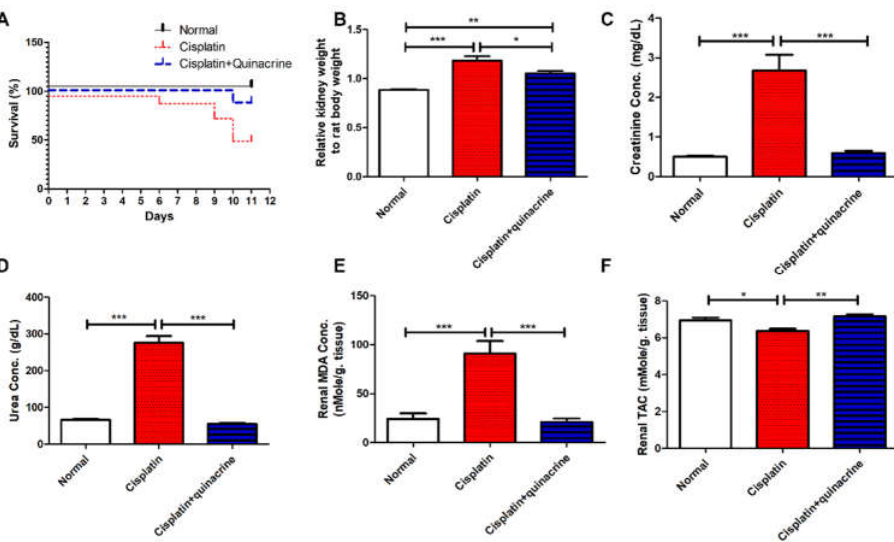
Figure 1. Quinacrine attenuated cisplatin-induced mortality, nephrotoxicity and oxidative stress. Effect of 10 days’ administration of quinacrine (10 mg/kg/rat/ day, intraperitoneal) against cisplatin-induced nephrotoxicity in rats on ( A ) % survival ( n = 7–8), ( B ) relative kidney to rat body weight ratio ( n = 7–8), ( C ) serum creatinine concentration, ( D ) serum urea concentration ( n = 7–8), ( E ) renal malondialdehyde (MDA) concentration ( n = 7–8) and ( F ) renal total antioxidant capacity (TAC) (n = 7–8). *: p < 0.05; **: p < 0.01 and *** p < 0.001. Data are expressed as mean ± SEM.